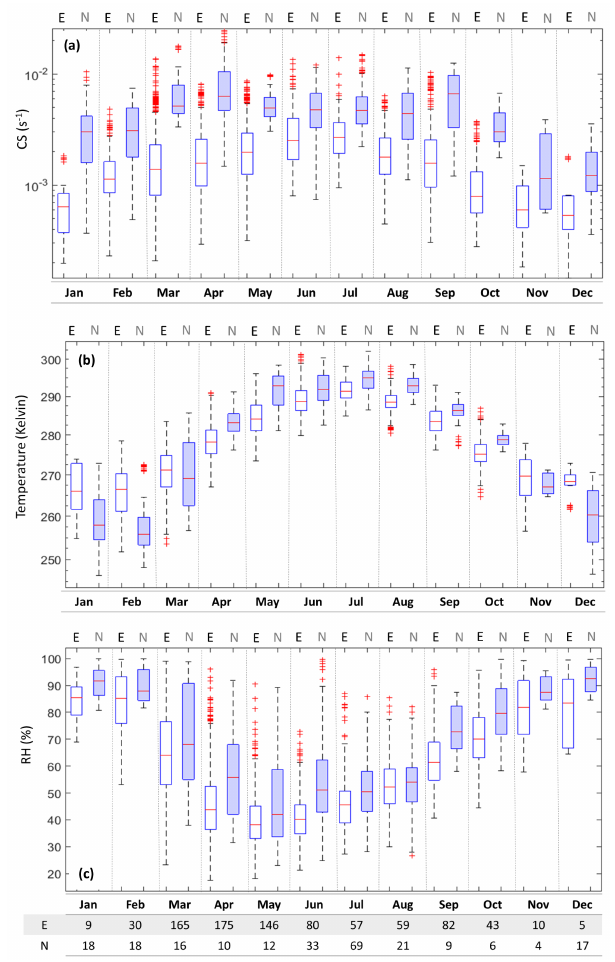
Figure 5. Median and percentiles of monthly variation (09:00– 12:00) at P >0.7 of (a) CS, (b) temperature and (c) RH during NPF events (E, white) and nonevents (N, shaded). See Fig. 1 for expla- nation of symbols.